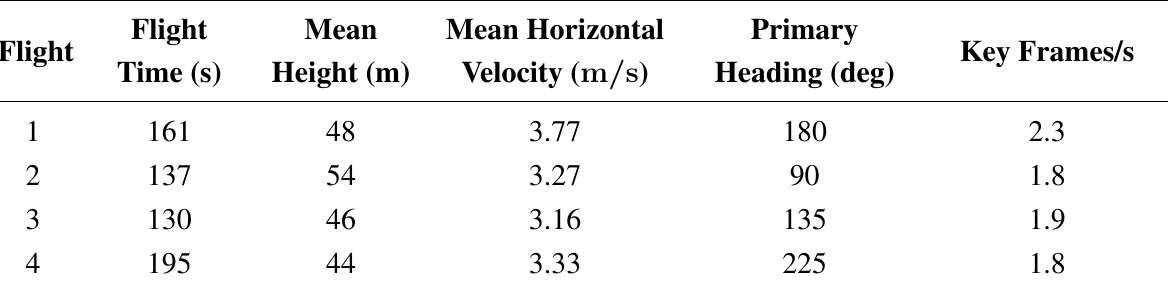
Table 2. Summary of the four flights flown over the study